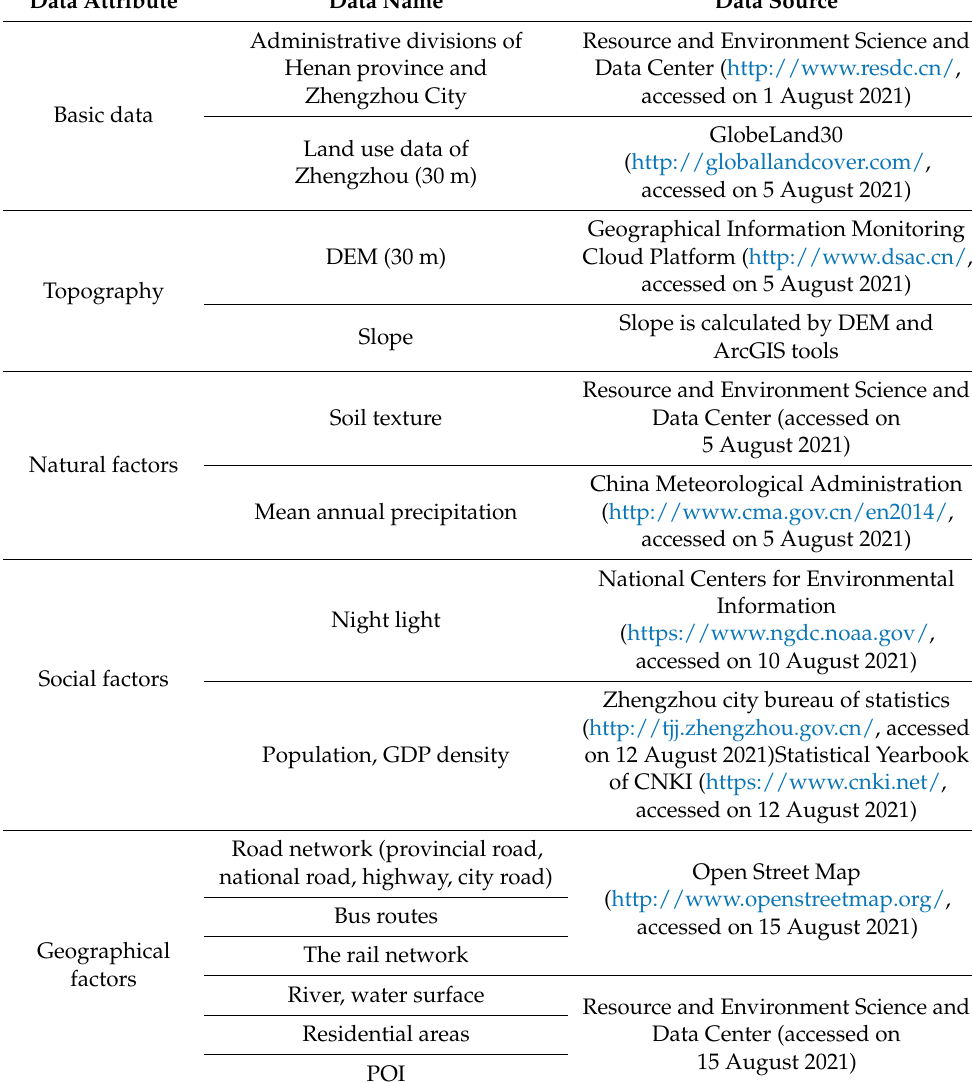
Table 1. Information on data